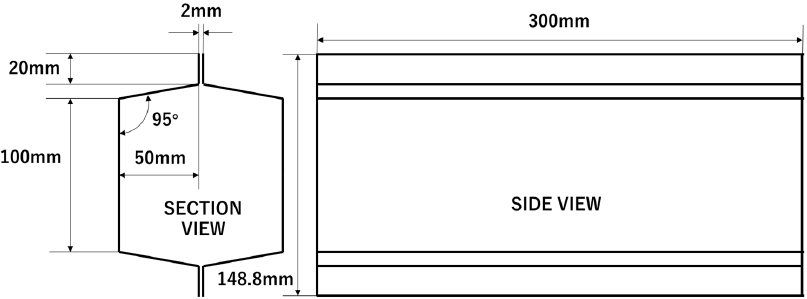
Figure 3. Dimensions of crash box.